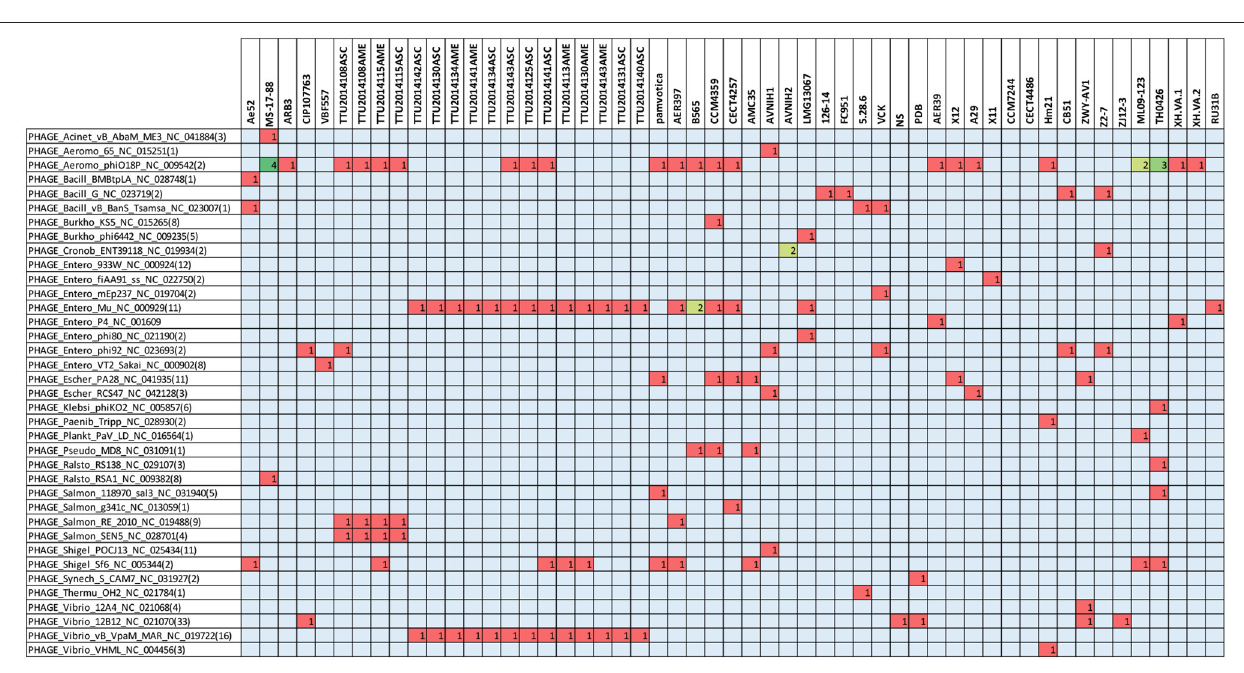
FIGURE 5 | Type of prophage elements present in the A. veronii genomes. Red color represents presence of the